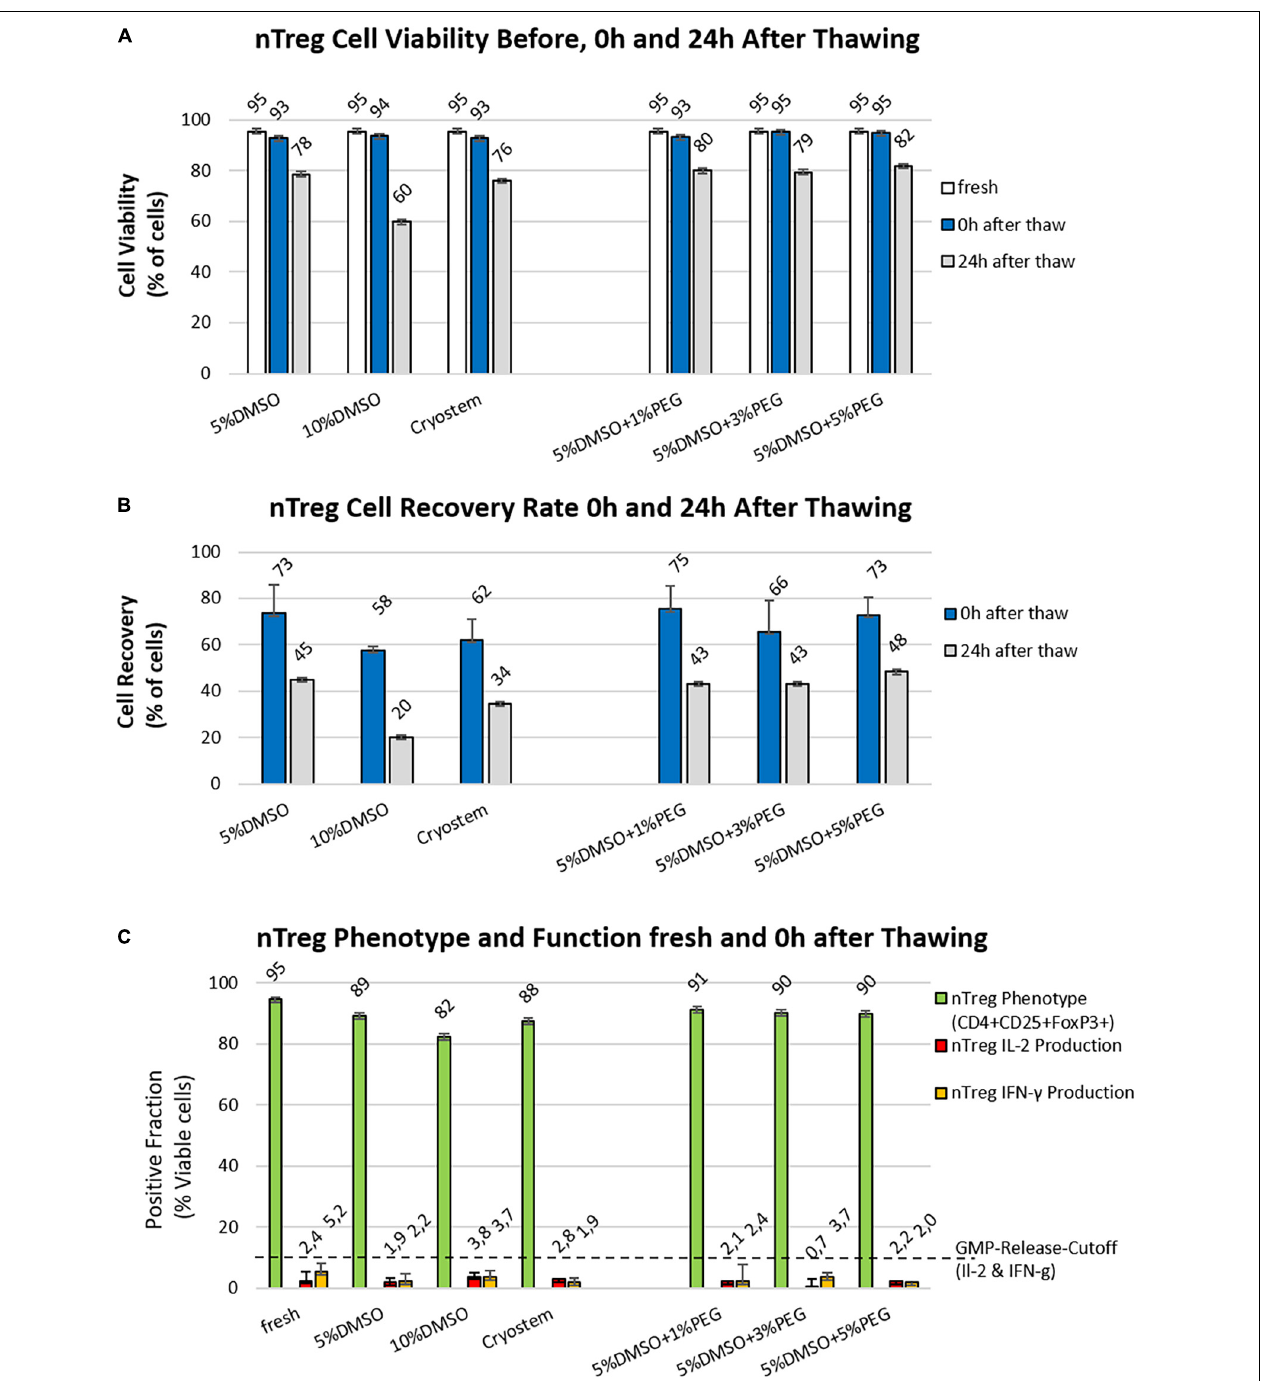
FIGURE 2 | Optimizing nTreg cell viability and recovery post thawing. (A,B) Different readout parameters before freezing (white) and at 0 h (blue bars) or 24 h post thawing (gray bars) are shown for the six freezing media as listed in Table 1 ( n = 2 cell products produced under GMP-like conditions). (A) Viability (%): There is only a small difference in viability between fresh cells and all the other preparations directly after thawing, but strong decreases are found at 24 h depending on the approach, freezing medium with 10% DMSO content performed the worst, while addition of PEG brings only minimal improvement in viability at 24 h compared to the freezing medium with 5% DMSO content; (B) Cell Recovery (%): Analysis at 24 h time point gives a more informative readout on quantitative differences and best performance with 5% DMSO; and (C) Phenotypic and Functional Analysis: Shown are the results of phenotyping as well as cytokine secreting cells before freezing (fresh) and after cryopreservation (thawed) for the investigated 6 different freezing media for the two initial nTreg cell products. The green bars show the percentage of Treg cells (% CD4+CD25+Foxp3+), the red bars represent the percentage of interleukin 2 (IL2)-producing cells, and the yellow bars show the percentage of interferon gamma (IFN- G )-secreting cells both expressed as % positive